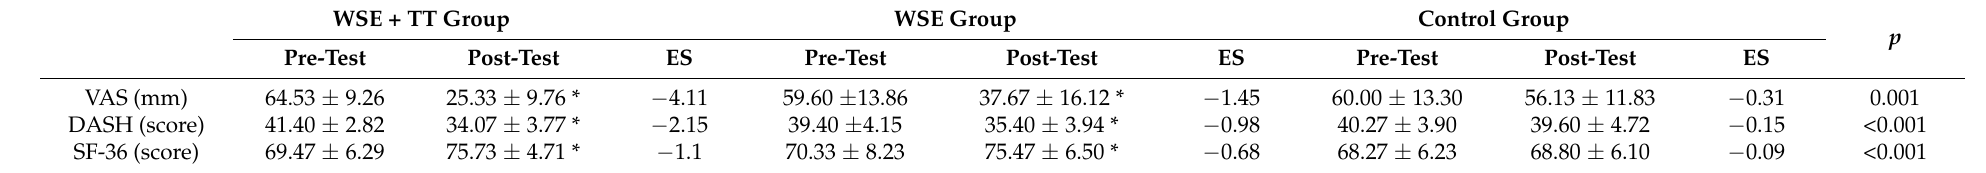
Table 2. Comparison pre-test and post-test among the three groups ( n = 45).